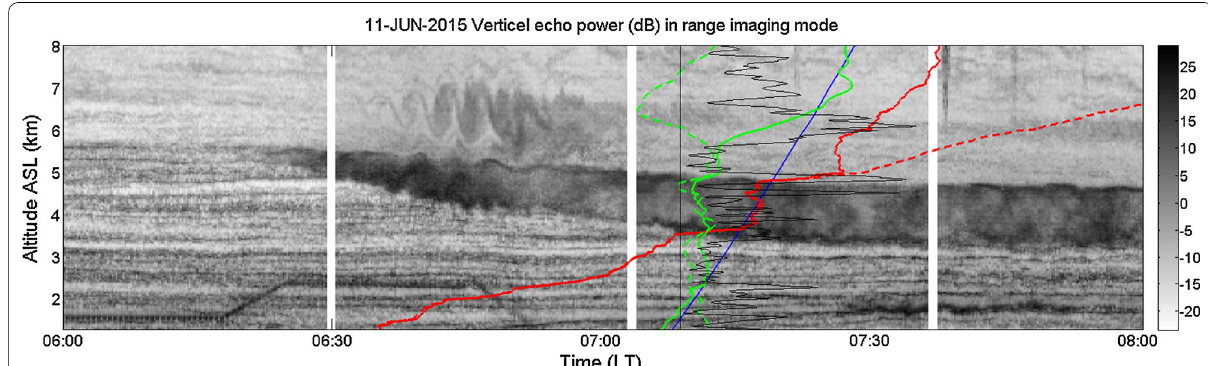
Fig. 2 Time–height cross section of Capon-processed radar echo power at vertical incidence for the period 0600–1200 LT on June 11, 2015. The white vertical bands correspond to radar stops at regular time intervals. The blue line shows the altitude versus time of a Vaisala RS92G Radiosonde launched from the observatory at 0706 LT. Solid and dashed red curves are (scaled) moist and dry potential temperature profiles. Solid and dashed green curves are the (scaled) profiles of meridional and zonal wind components, respectively. The black curve shows the (scaled) profile of vertical shear of horizontal wind vector. The null value is given by the vertical black